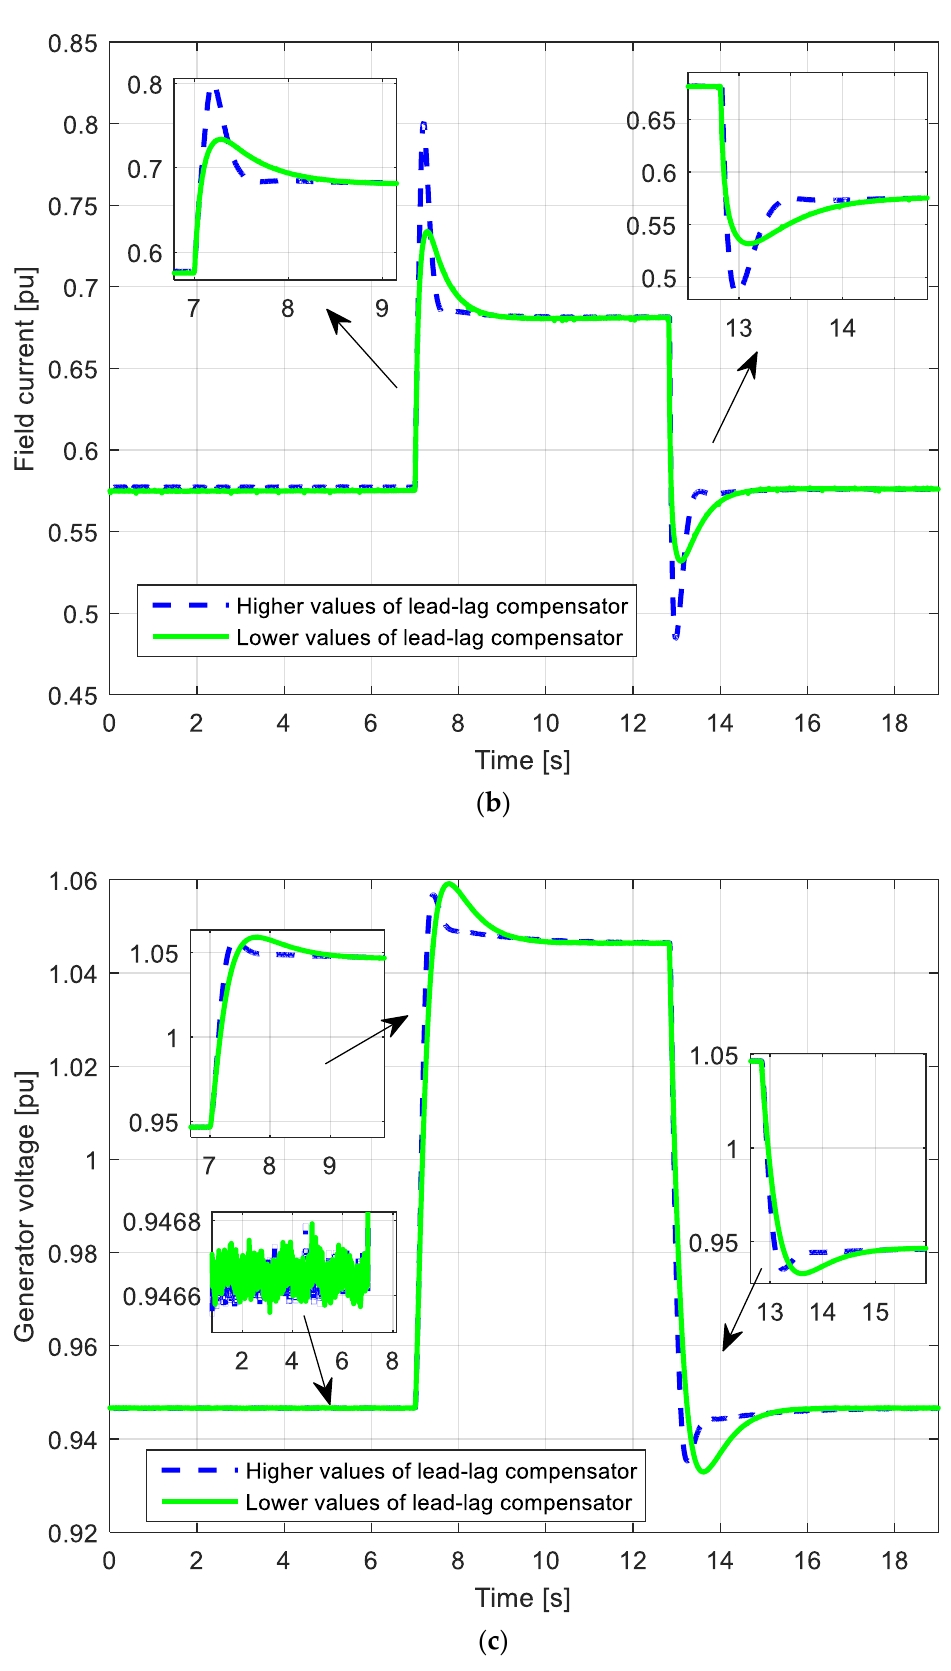
Figure 20. Experimental results: ( a ) field voltage ( b ) field current, and ( c ) generator voltage. The sudden change of the generator voltage set-point leads to a sudden rise of the excitation voltage. This very fast change enables the thyristor bridge operation in the static excitation system. The rise of the excitation voltage leads to the rise of the excitation cur- rent, and finally leads to the rise of output generator voltage.